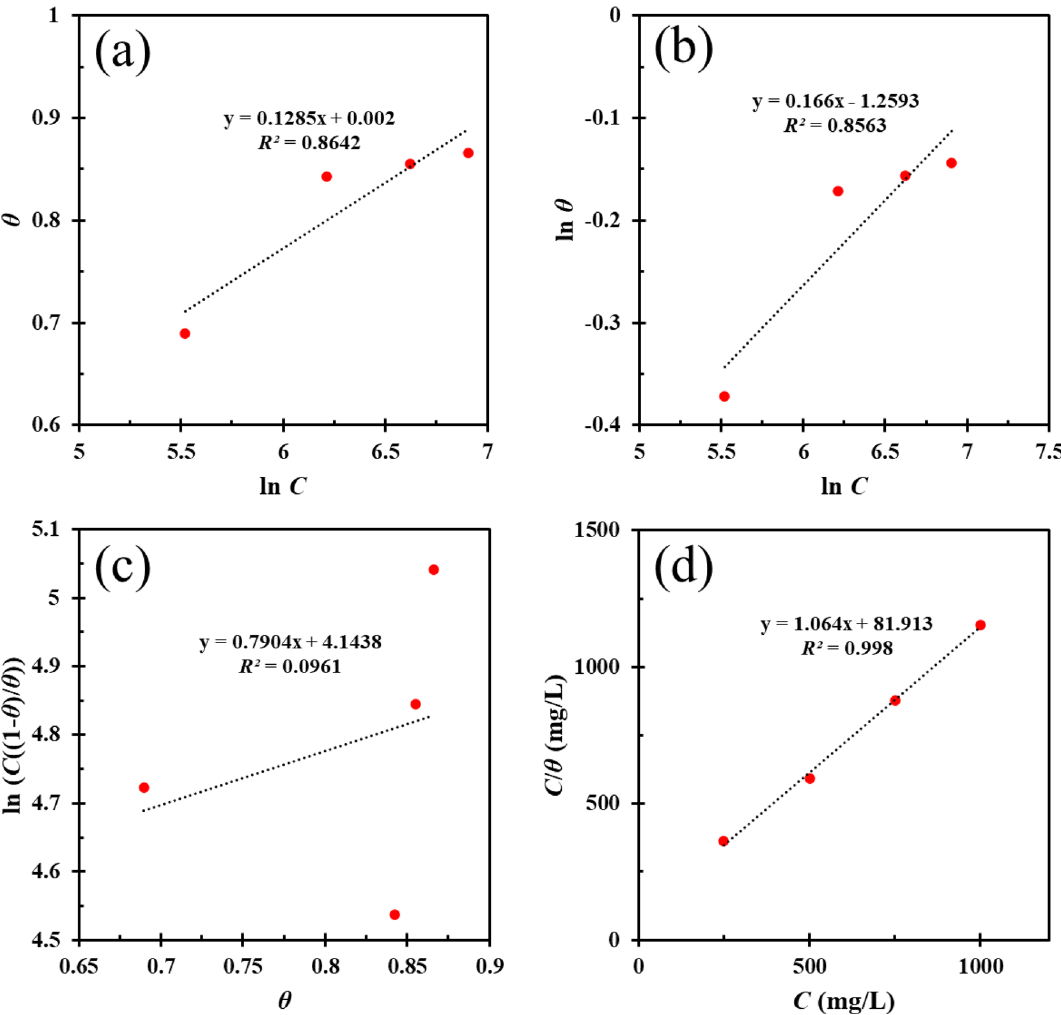
Figure 4. Temkin ( a ), Freundlich ( b ), Frumkin ( c ), and Langmuir ( d ) isotherms used for studying adsorption of DPH on MS surface after 24 h immersion of MS in 1 M HCl solution containing 0–1000 ppm DPH at room temperature. (cid:31) G 0 ads (kJ/mol) K L (l/mg) R 2 − 21.35 0.0122 Table 4. Langmuir isotherm parameters for DPH adsorbed onto MS surface submerged in 1 M HCl solution containing 0–1000 ppm DPH at 298 K.